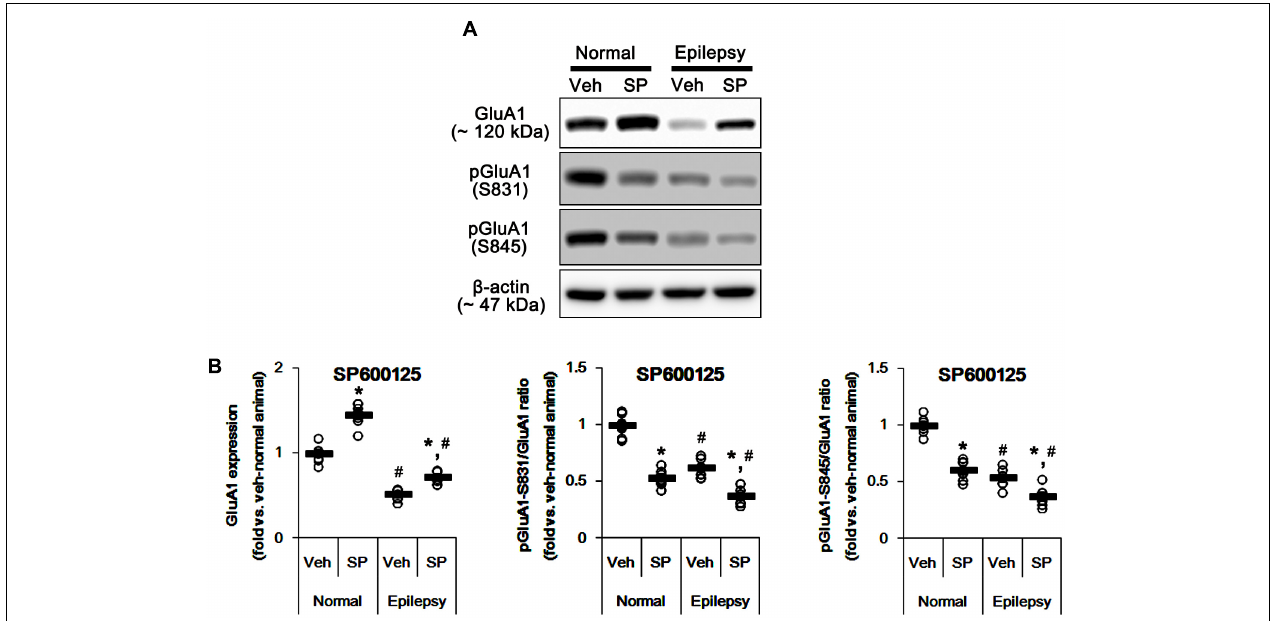
FIGURE 9 | Effects of SP600125 (SP) on GluA expressions and their phosphorylations. (A) Representative images for western blot of GluA1, phospho (p)-GluA1-S831, and pGluA1-S845 in the hippocampal tissues obtained from 3-days infused groups. (B) Quantifications of GluA1, pGluA1-S831, and pGluA1-S845 levels in SP600125-infused groups. Open circles indicate each individual value. Horizontal bars indicate mean value. Error bars indicate SEM ( ∗ , # p < 0.05 vs. vehicle-treated animals and normal animals, respectively; n = 7, respectively).